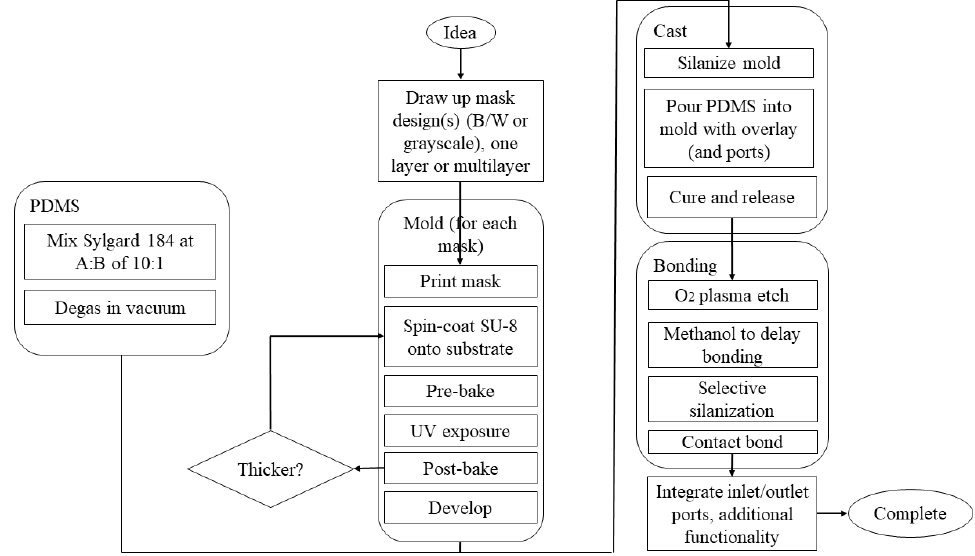
Figure 3. Process of making microfluidic devices using PDMS . Different materials are used to produce the mold, but SU-8 is usually chosen in the production of PDMS-based microfluidic devices. Once the mold has been prepared with the appropriate steps, the next step is casting, followed by hardening and release of PDMS from the mold. The PDMS is deposited on the mold; everything is placed in the oven for 24 h at 65 °C so that the PDMS cures and, once hardened, can be easily removed from the mold. Then, the bonding phase follows, where the surface of the PDMS is generally exposed to oxygen plasma for 10 min and then in contact with a layer of glass or another layer of PDMS to generate a bond. The process ends with the interfacing and integration phase where input and output zones are created with the help of needles, in the case of temporary applications, or with specific structures for longer applications. Reprinted with permission from [207]. Copyright 2022, AIP Publishing LLC.